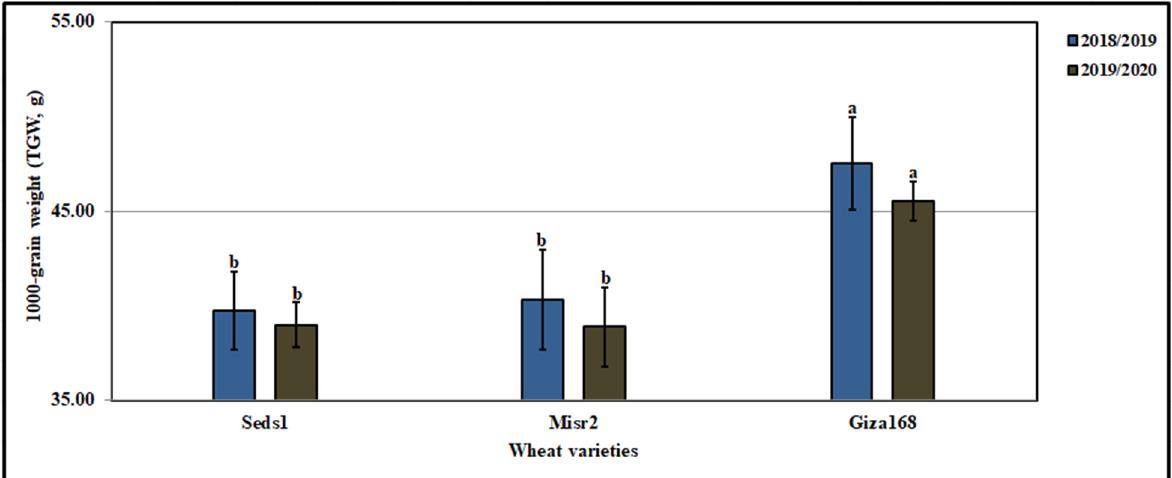
Figure 16. Influence of wheat varieties on 1000-grain weight (TGW, g) in clay loam soil in 2018/2019 and 2019/2020 seasons. Bars in the same years with a different letter indicate significant differences between treatments at p ≤ 0.01. HS 1, HS 2 , HS 3 represent HS applied as foliar spray at 1.0, 2.0, 4.0 g L − 1 , respectively, HS 4 , HS 5 , HS 6 represent HS applied as soil application at 5.04, 7.56, 10.08 kg ha − 1 .